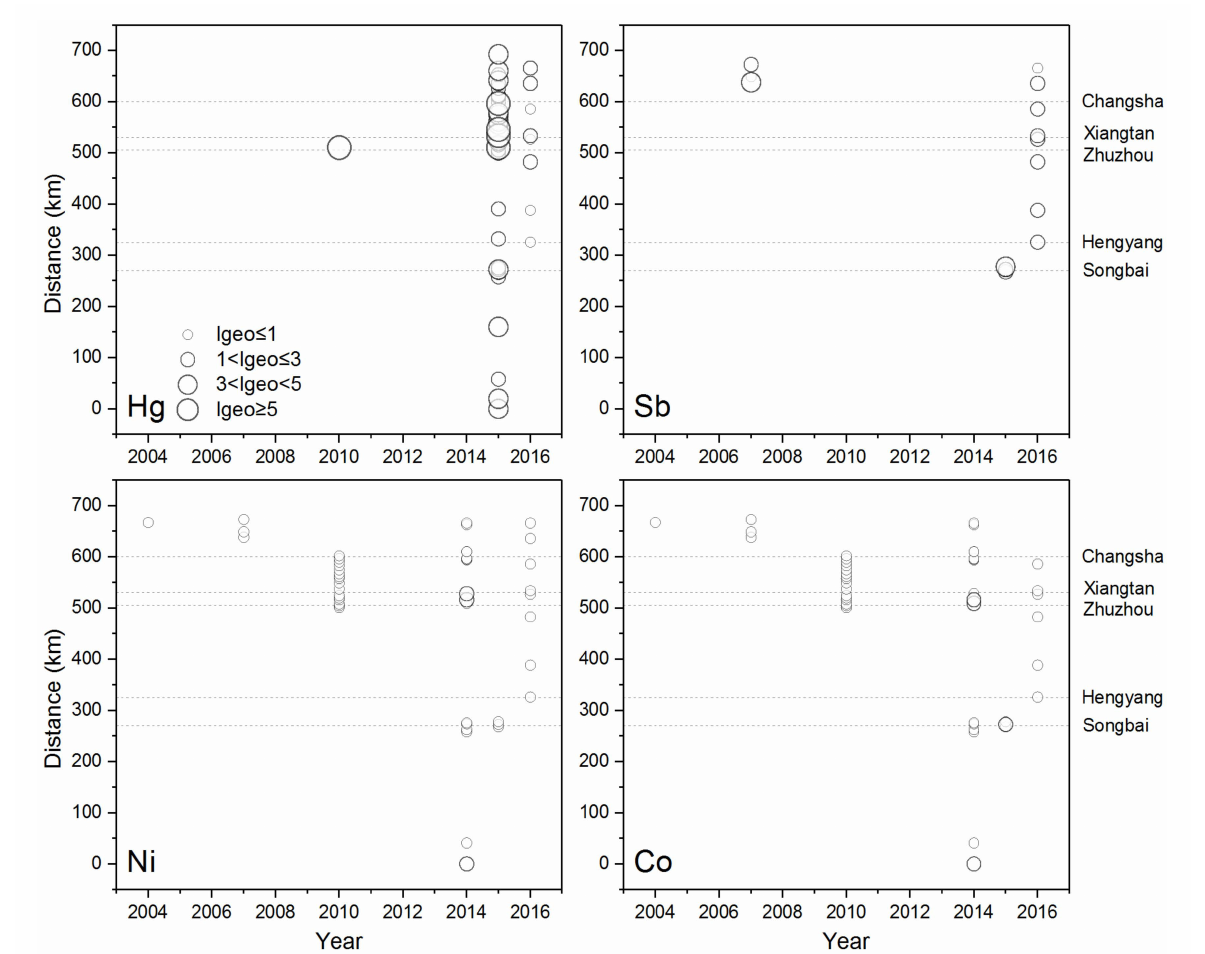
Figure 2. Spatial and temporal distribution of geo-accumulation indexes I geo for some selected trace elements in the mainstream sediments of the Xiangjiang River, based on this study and a literature review (Table S1). All the elements use a geochemical background level, defined locally (Table S2). I geo scale is the same except for Cd. Songbai: KP 270,